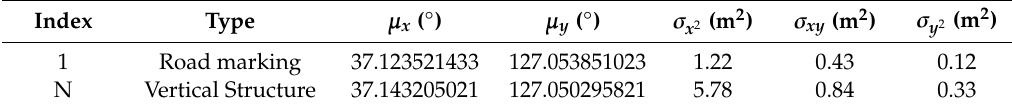
Table 1. Example of the FRPDM.